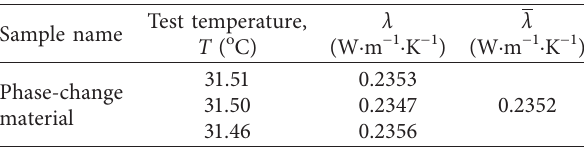
Figure 4: FT-IR spectrum of C Table 4: Thermal conductivity of PCM at the eutectic point a . Test temperature, Sample name T ( o C)